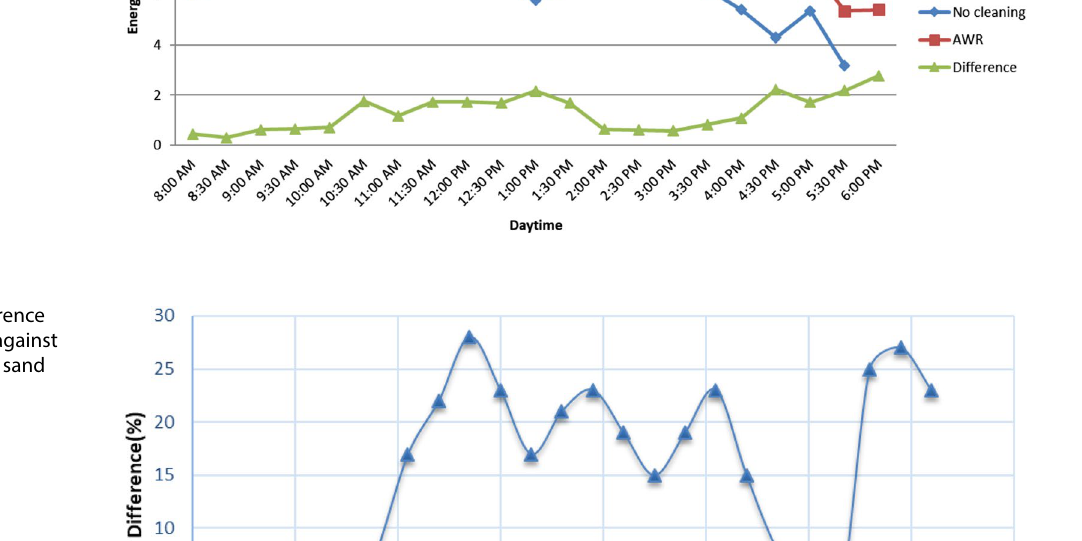
Fig. 8 Comparison of the deliv- ered energy and energy differ- ence between AWR method and no-cleaning systems